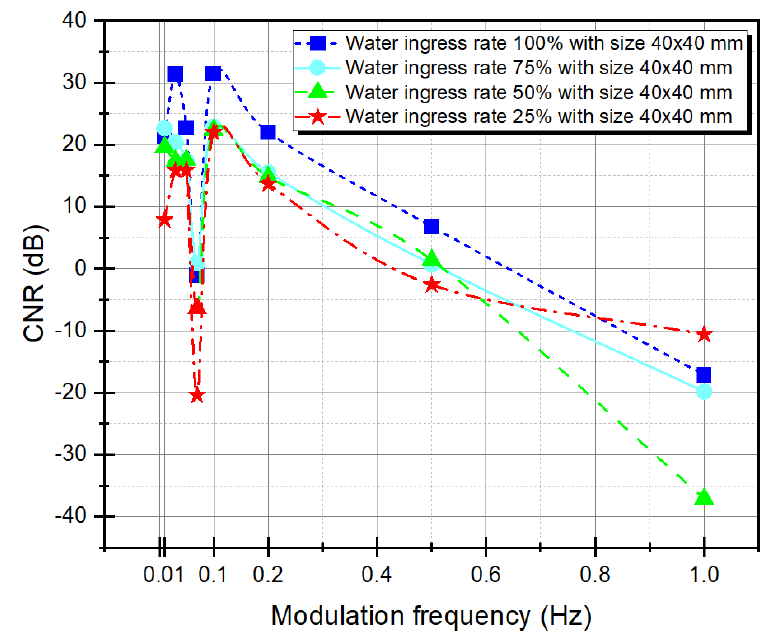
Figure 8. Phase-contrast with four-point method as a function of modulation frequency.